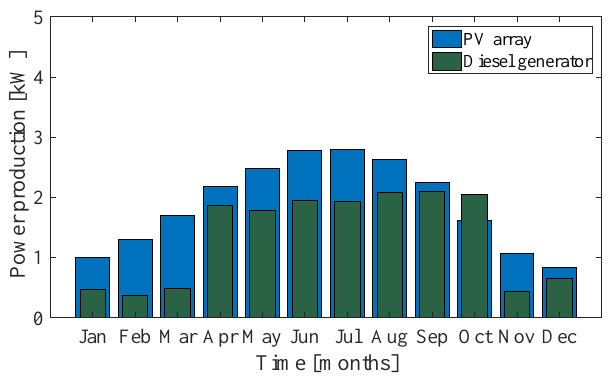
Figure 7. Monthly average electrical production for design